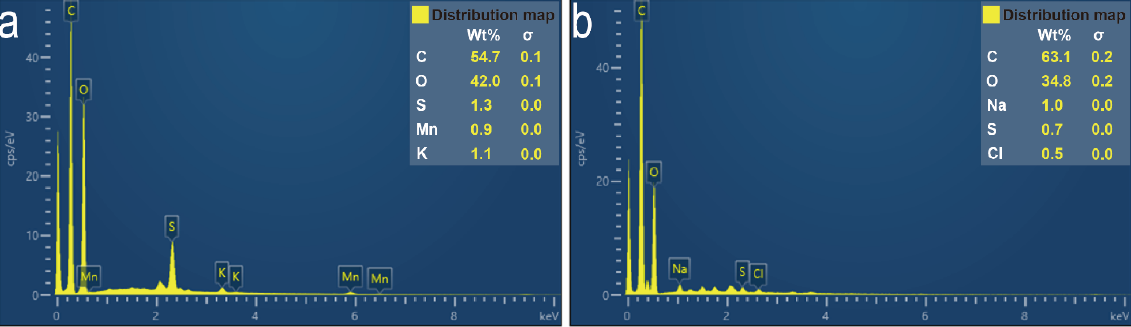
Figure 4. EDS spectra of GO ( a ) and rGO ( b ).